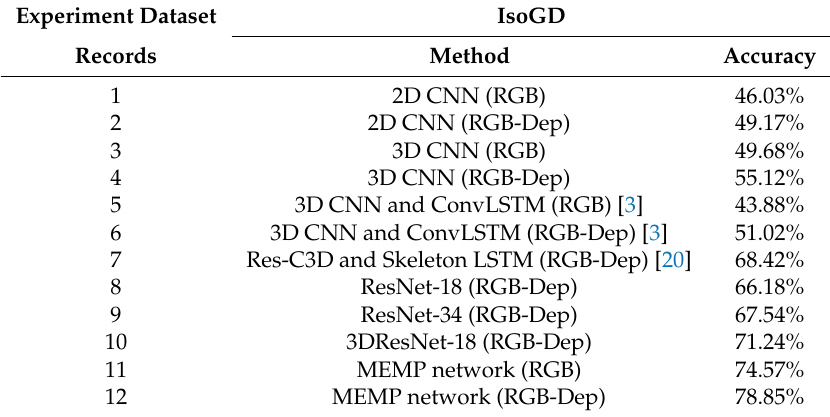
Table 5. IsoGD experimental